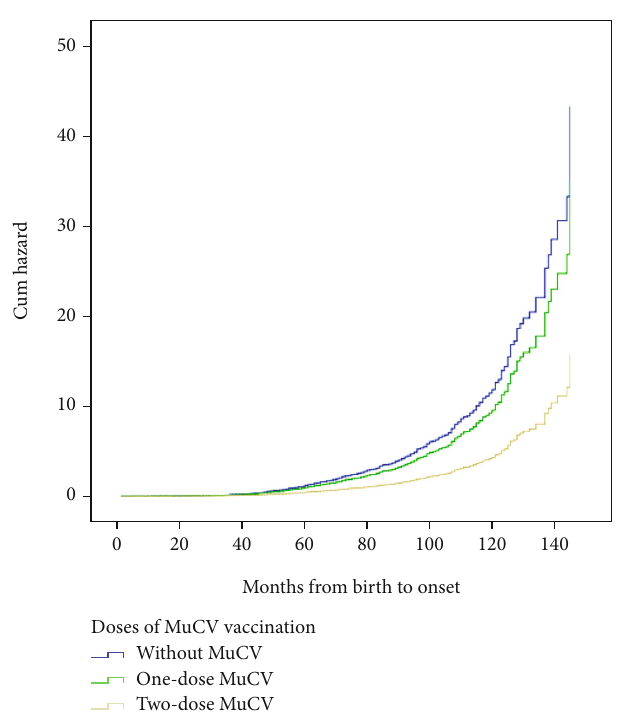
Figure 2: The Cox-proportional hazard curves showing the cumulative hazard with di ff erent